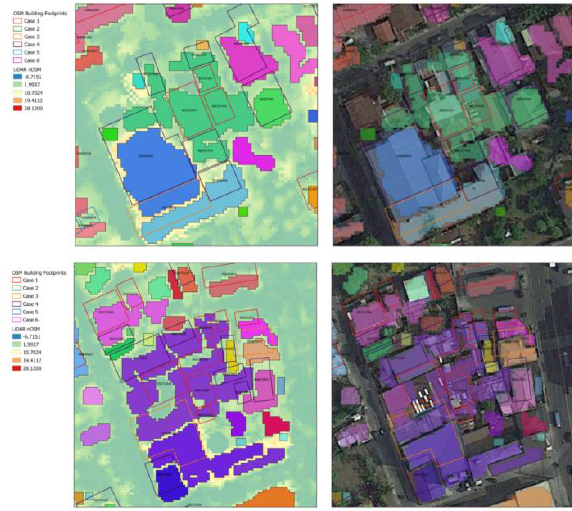
Figure 5. Areas showing under-segmentation of detected nDSM buildings.